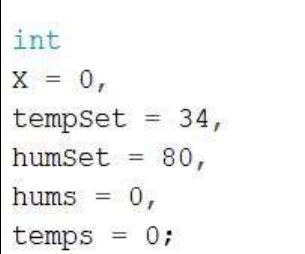
Figure 3. Code 2 — humidity and temperature limit values.